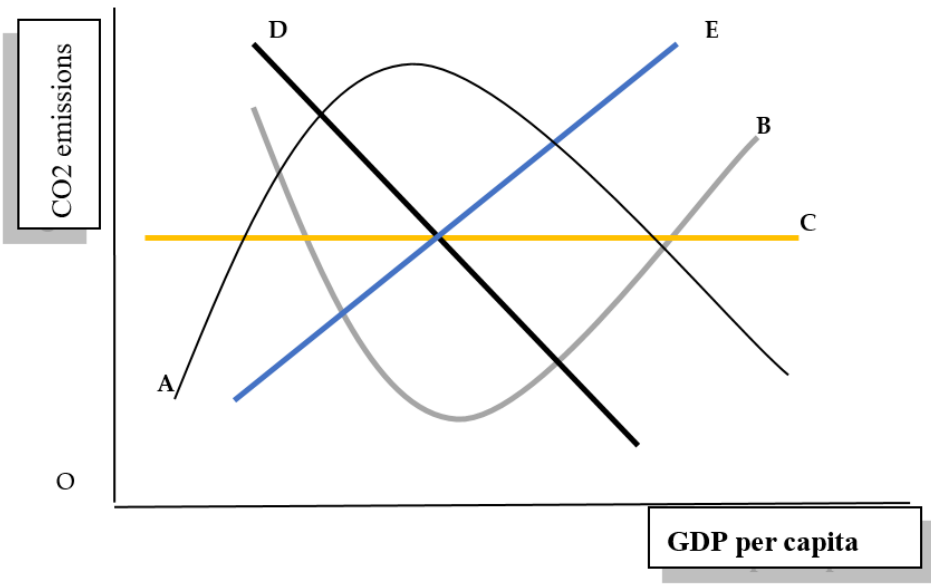
Figure 2. Different possibilities of EKC Formulation from Line A to E. Source: Extracted from the scholarly work of Dinda [50,51]. Note: ‘A’ line shows inverted U-shaped EKC hypothesis, ‘B’ line shows a U-shaped relationship, ‘C’ line shows the flat relationship, ‘D’ shows the monotonic decreasing relationship, and ‘E’ shows the monotonic increasing relationship between the